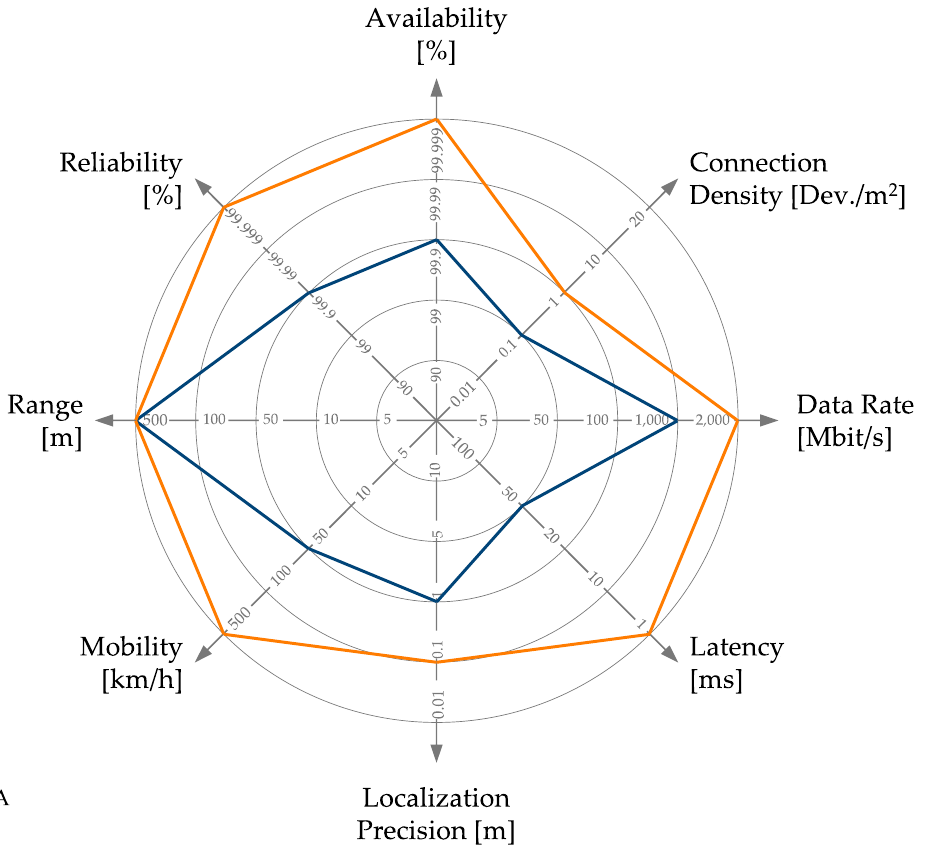
Figure 4. Maximum performance characteristics of fourth- and fifth-generation (4G and 5G) tech- nology.